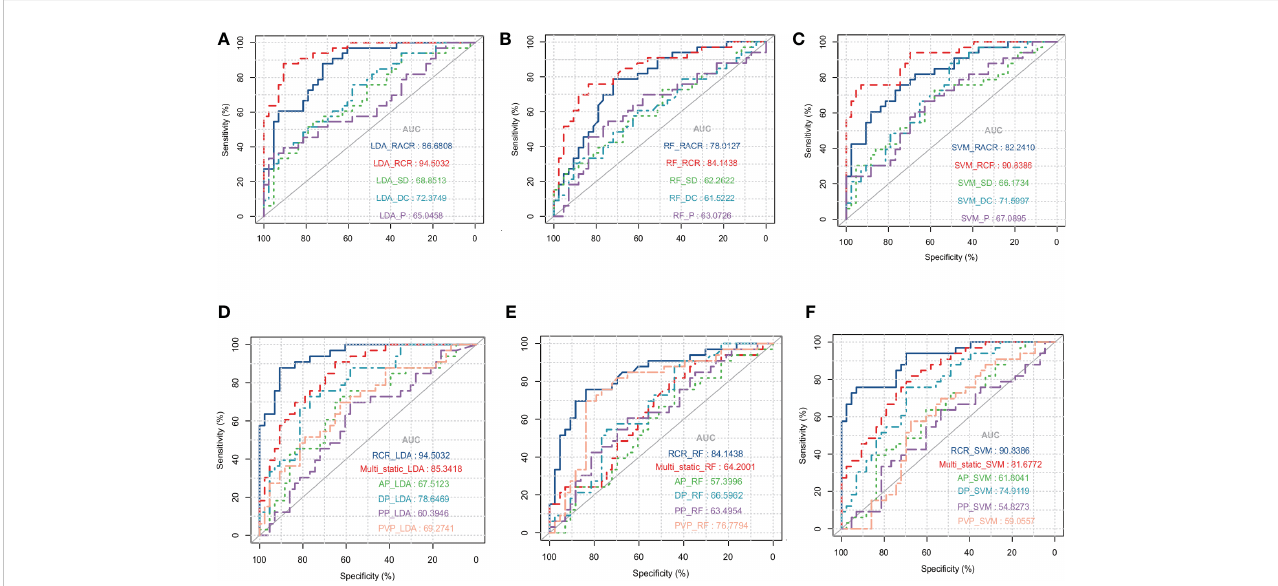
FIGURE 3 ROC curves for LDA (A) , RF (B) and SVM (C) models with different dynamic features when using leave-one-out cross-validation. ROC curves for LDA (D) , RF (E) , and SVM (F) models with static features of different series and RCR features when using leave-one-out cross-validation, where Multi_static refers to the feature set analysis of multiple series.